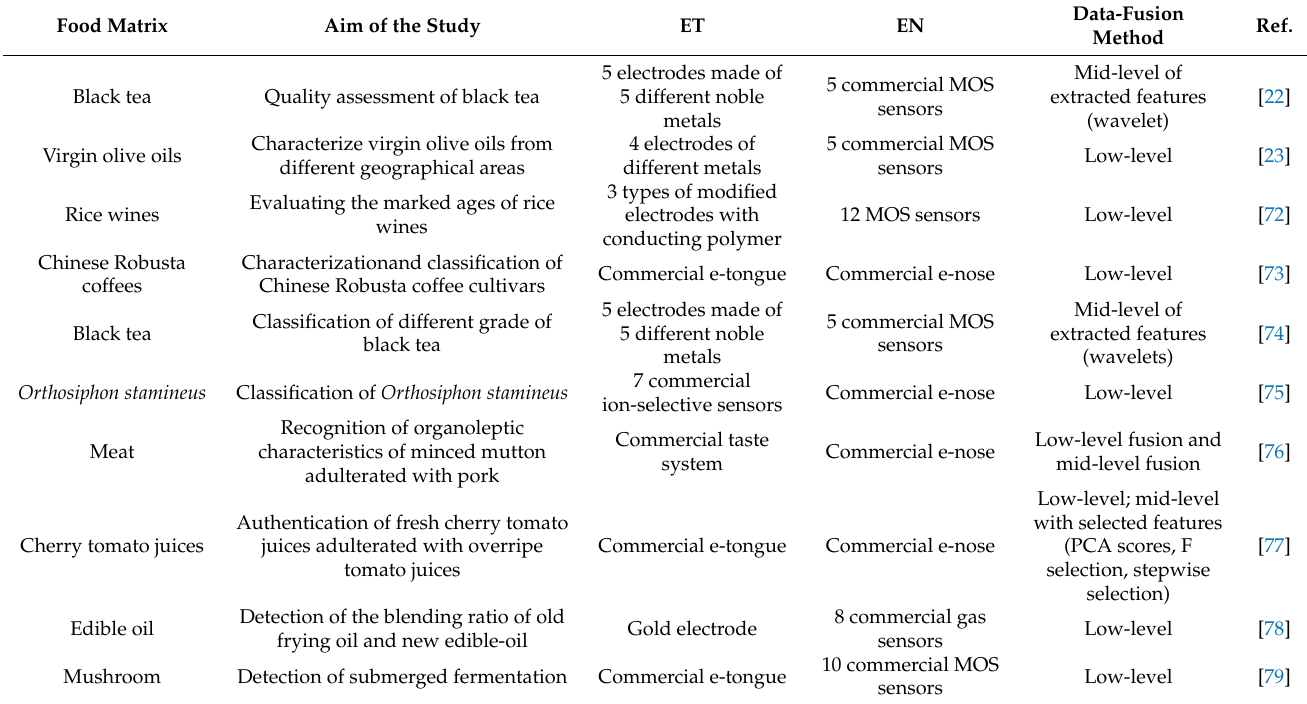
Table 2. List of publications related to the application of combined ET and